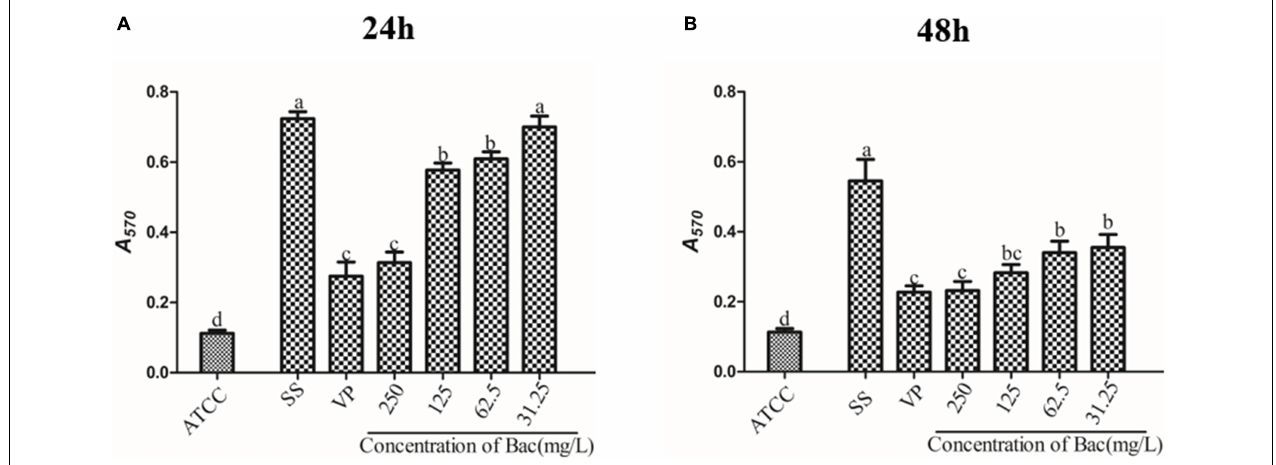
FIGURE 4 | The influence on the biofilm formation ability of baicalin and verapamil. The crystal violet assay assessed the biomass of ATCC 15305 and ARSS after exposure to 250, 125, 62.5, and 31.25 mg/L baicalin and 250 mg/L verapamil for 24 h (A) and 48 h (B) . Bars in the same index without the same letters differ significantly ( p <